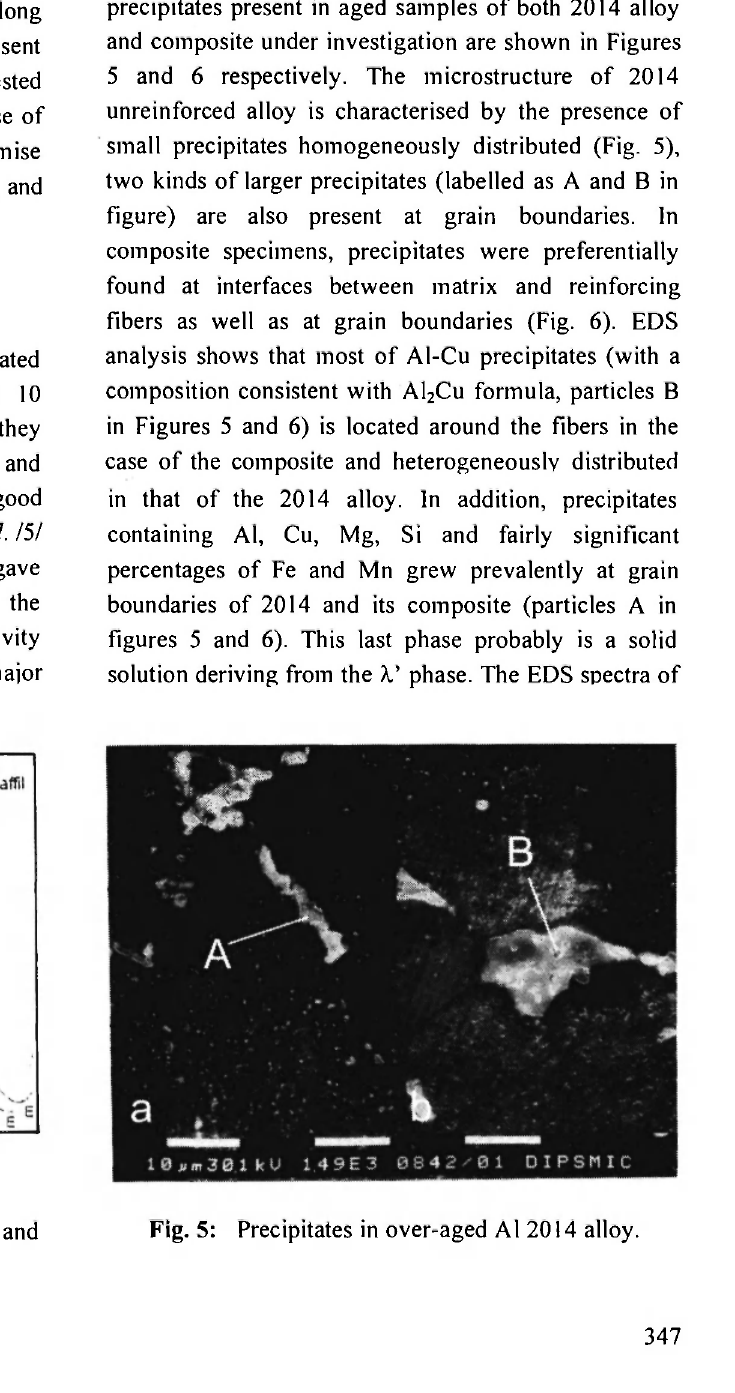
Fig. 4: DSC traces for solution treated composite and unreinforced alloy.